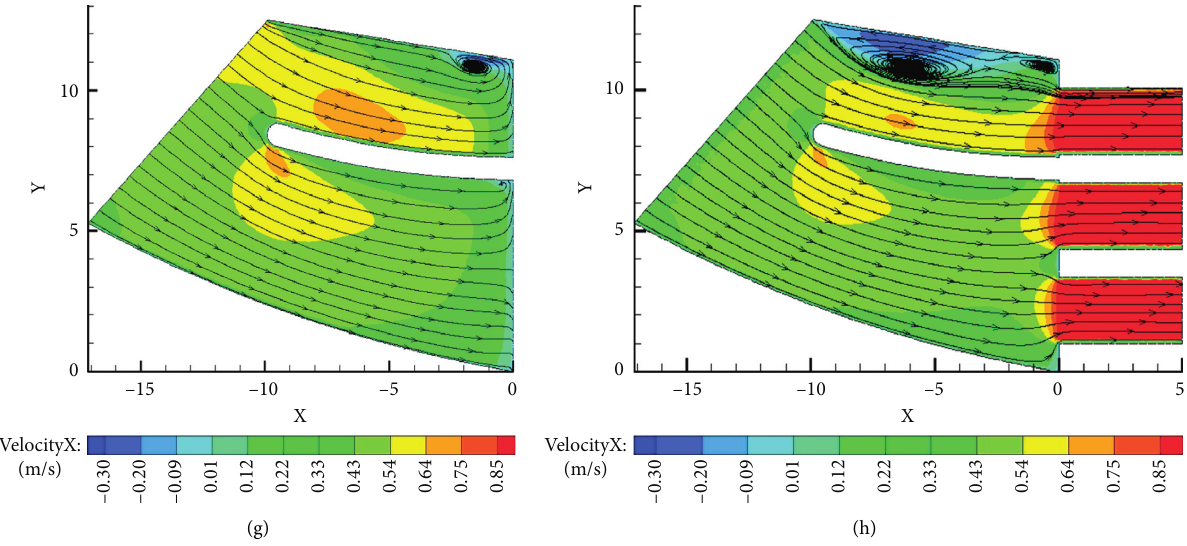
Figure 5: Flow field diagrams of the horizontal section of the surface layer and bottom layer of different schemes. (a) L4 surface layer flow field distribution. (b) L4 bottom layer flow field distribution. (c) L7 surface layer flow field distribution. (d) L7 bottom layer flow field distribution. (e) L11 surface layer flow field distribution. (f) L11 bottom layer flow field distribution. (g) L15 surface layer flow field distribution. (h) L15 bottom layer flow field